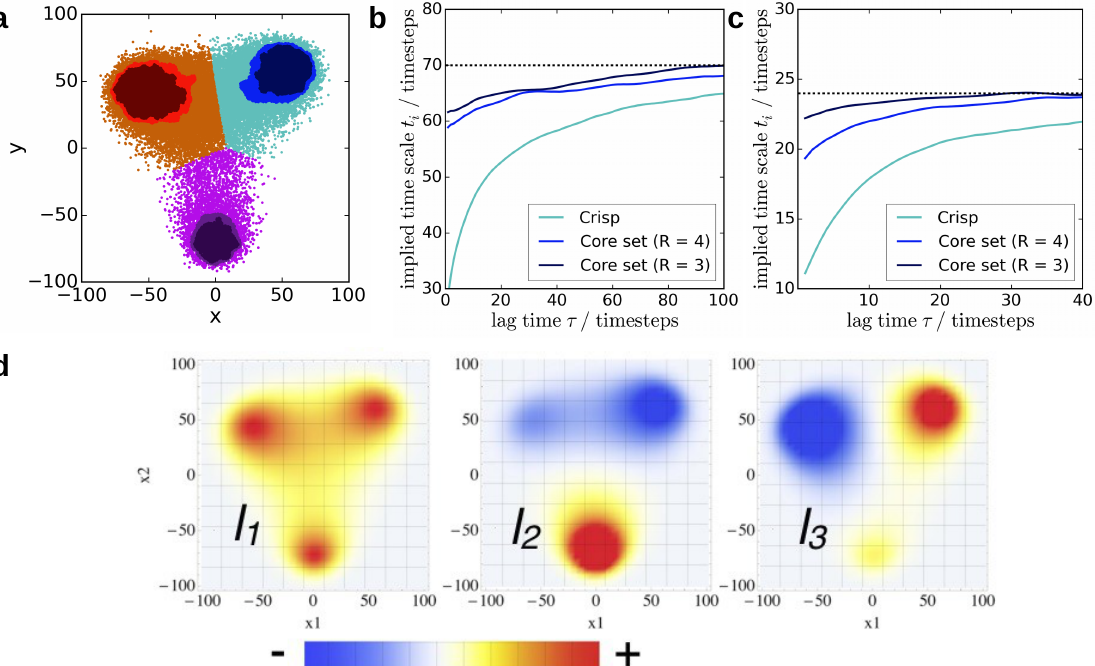
Figure 8. ( a ) Core sets of the two-dimensional (2D) potential energy surface (PES) using different parameter sets. A smaller core set corresponds to a smaller cutoff radius. Implied time scales (colored according to the upper right cluster in ( a )) of the slower process ( b ) and the faster process ( c ). The black dashed line denotes the convergence limit. ( d ) Corresponding eigenvectors to the slow processes: Stationary distribution ( left ), slower process ( middle ), and faster process ( right ). The eigenvectors describe transitions of probability density between states with different sign (highlighted by the